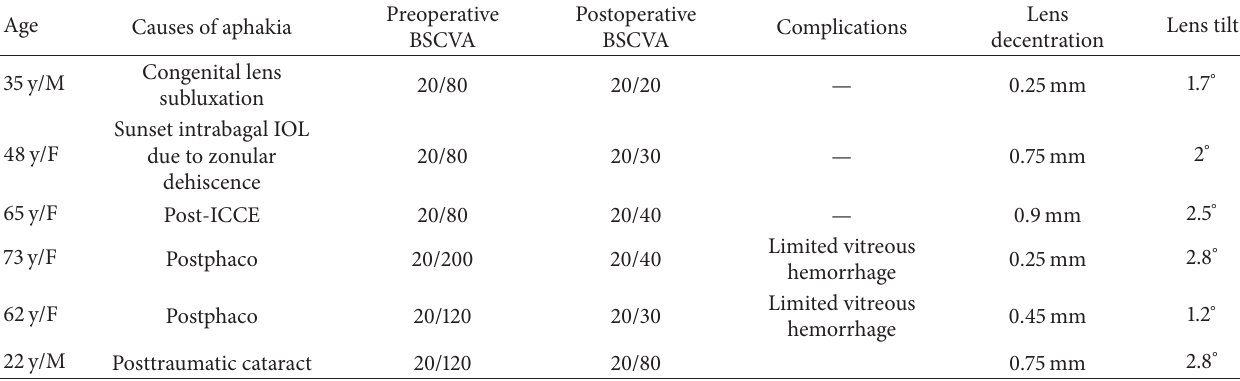
Table 1: Pre- and postoperative results for patients who underwent the balanced two strings scleral fixation